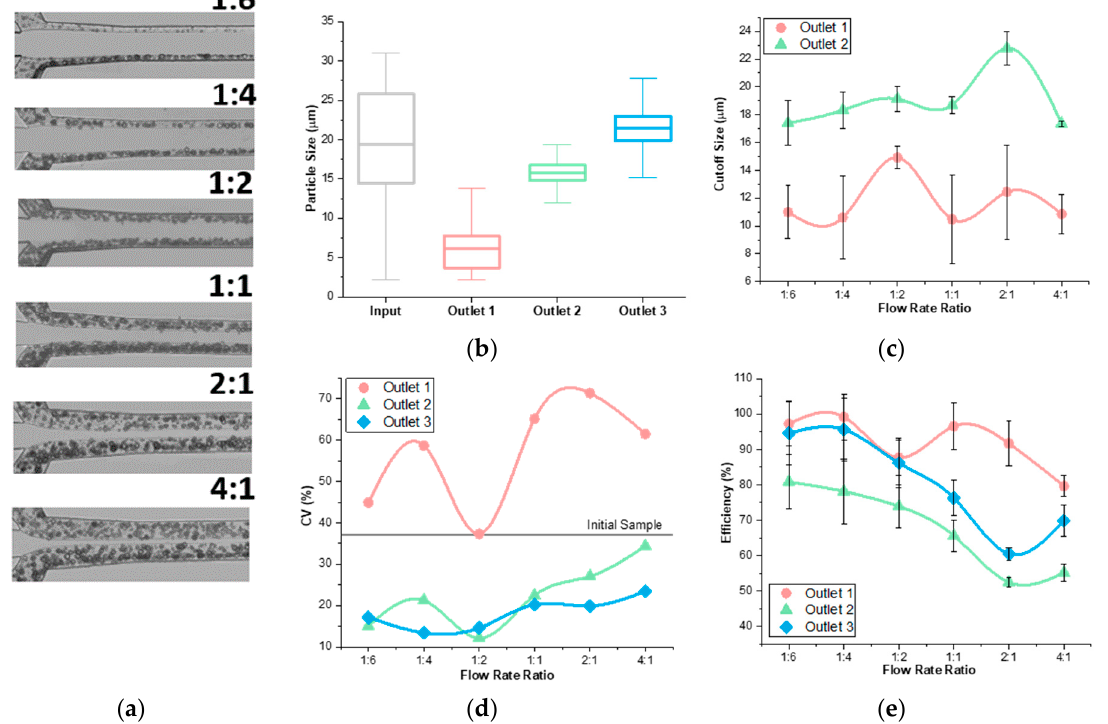
Figure 4. Influence of flow rate ratio on device performance. ( a ) Bright field images of flow show the boundary lines gets closer to the center and the width of the initial particle positions increases as the flow rate ratio increases. ( b ) The distribution of particles decreases from initial distribution in outlets for a flow rate of 300 μ L·min − 1 , at a 1:4 ratio and a 0.59 resistance ratio. ( c ) Cutoff size in outlets 1 and 2 change negligibly when flow rate ratio increases. ( d ) Coefficient of variance increases with increasing flow rate ratio. ( e ) Efficiency of separation decreases when flow rate ratio increases.